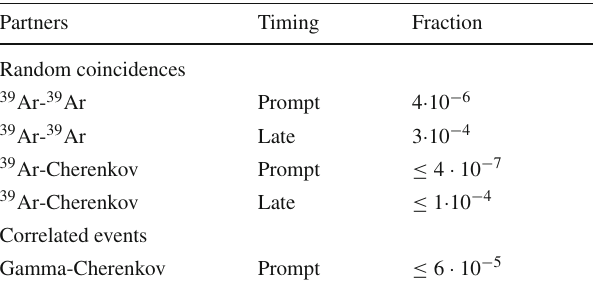
Table 1 Estimated fractions of events between 100 N nsc to 200 N nsc that are piled-up with a second event and not removed by the cuts, for different types of coincidences. ‘Timing’ distinguishes between coin- cidences that occur within the prompt F prompt window and those that